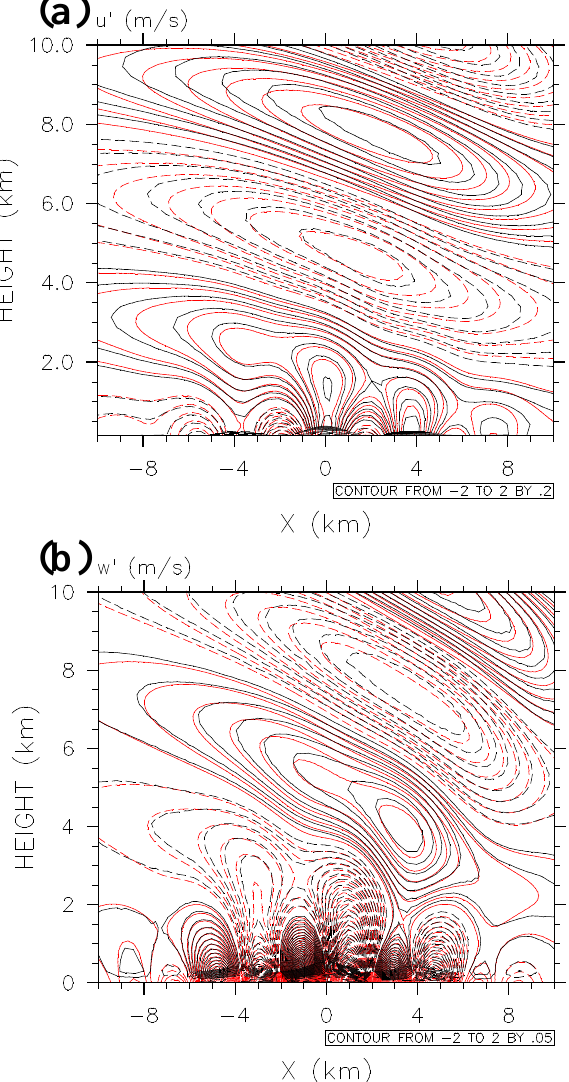
1 Figure 5. Steady-state flow of (a) perturbed horizontal velocity FIG. 5. Steady-state flow of (a) perturbed horizontal velocity ( 1 m s − ) and (b) vertical 2 33 (ms − 1 ) and (b) vertical velocity (ms − 1 ) over the Schär-type moun- tain after 10h with a grid resolution of (cid:49) ¯ x = 300m using fifth- velocity ( 1 m s − ) over Schär Mountain after 10 h with a grid resolution of 300x ∆ = m using 3 order basis polynomials per element and (cid:49) ¯ z = 250m. The numeri- cal solution is represented by black lines and the analytic solution is 5th-order basis polynomials per element and 250z ∆ = m. The numerical solution is 4 represented by red lines. Dashed lines denote negative values. The represented by black lines and the analytic solution is represented by red lines. Dashed lines 5 contour values are from − 2.0 to 2.0 with an interval of 0.2 (0.05) for the horizontal velocity (the vertical denote negative values. The contour values are from −2.0 to 2.0 with an interval of 0.2 (0.05) 6 for the horizontal velocity (the vertical velocity). 7